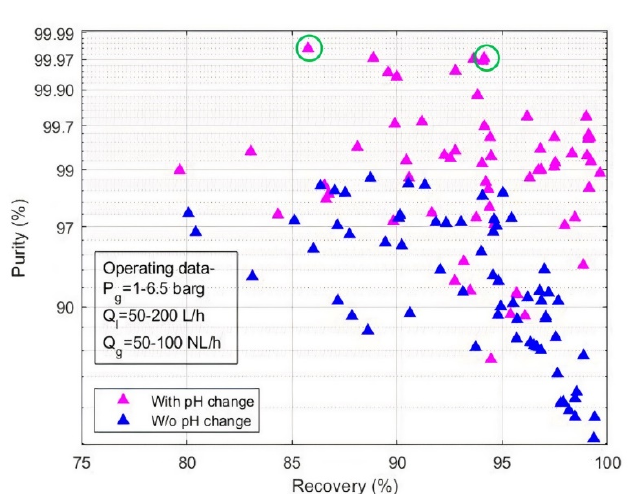
Figure 5. Experimental purity and recovery representing results with and without pH manipulation. (Absorbent: 1 M KCl, 0.5 M K 2 CO 3 and 0.01 M KHPO 4 , y in